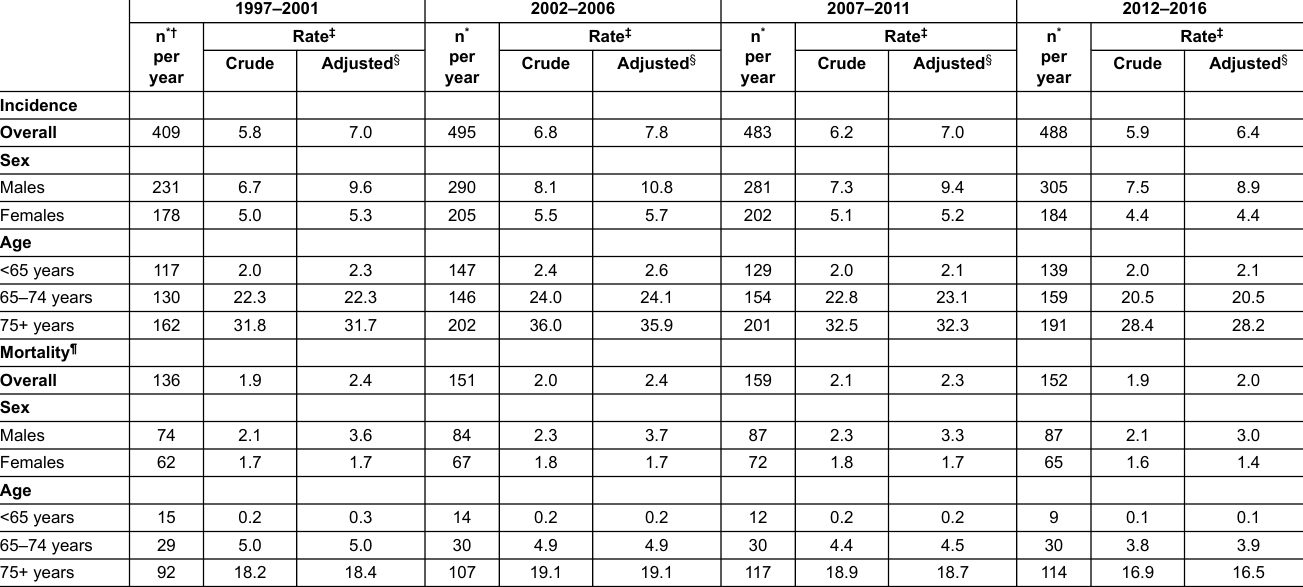
Table 2: Incidence and mortality of chronic lymphocytic leukaemia / small lymphocytic lymphoma in Switzerland,